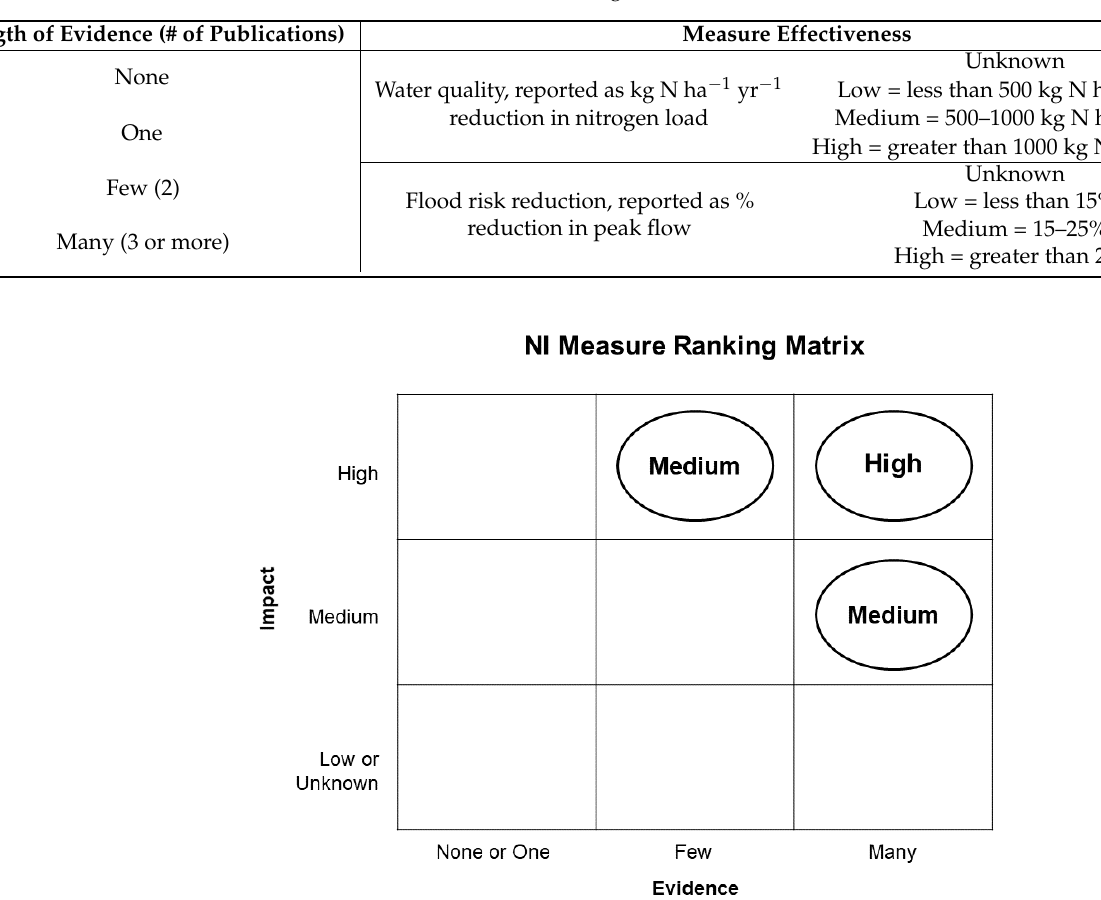
Table 2. Scoring rubric.